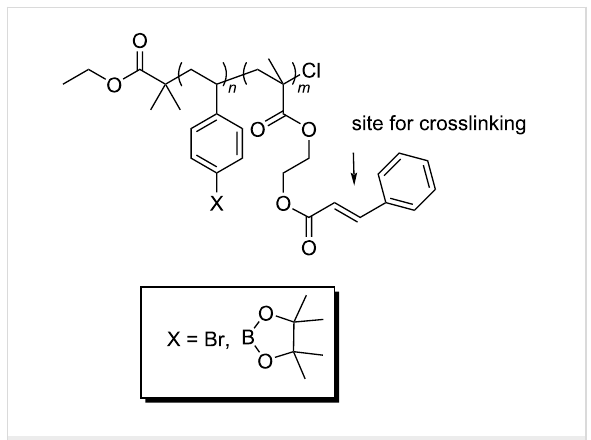
Figure 2: Diblock copolymers used for coating microelectrode arrays.